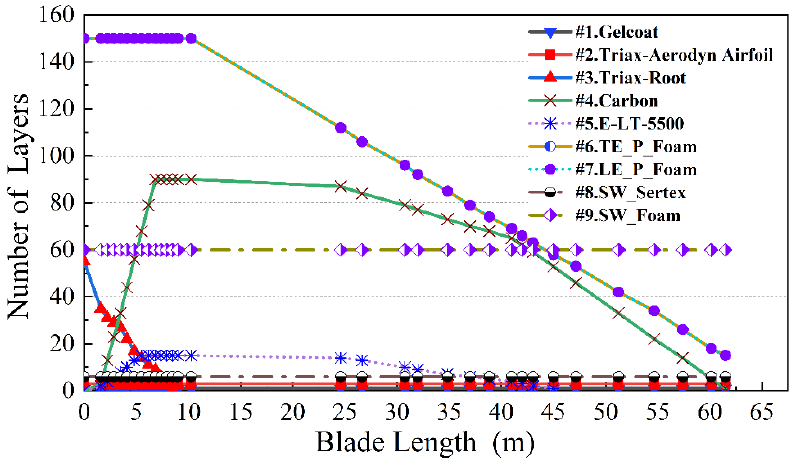
Figure 2. Layout of laminate in blade.